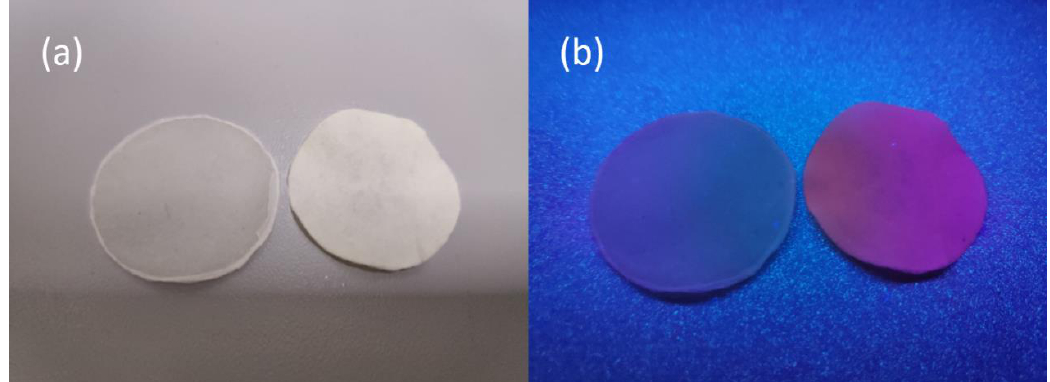
Figure 2. XPS spectra of ( a ) Eu-BC and ( b ) 20% Eu-BC fluorescent paper.